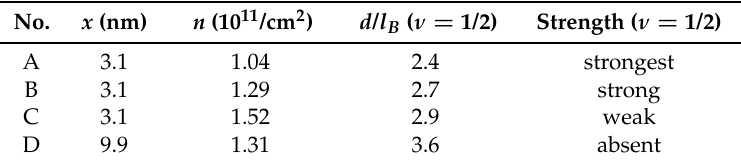
is observed); the 2